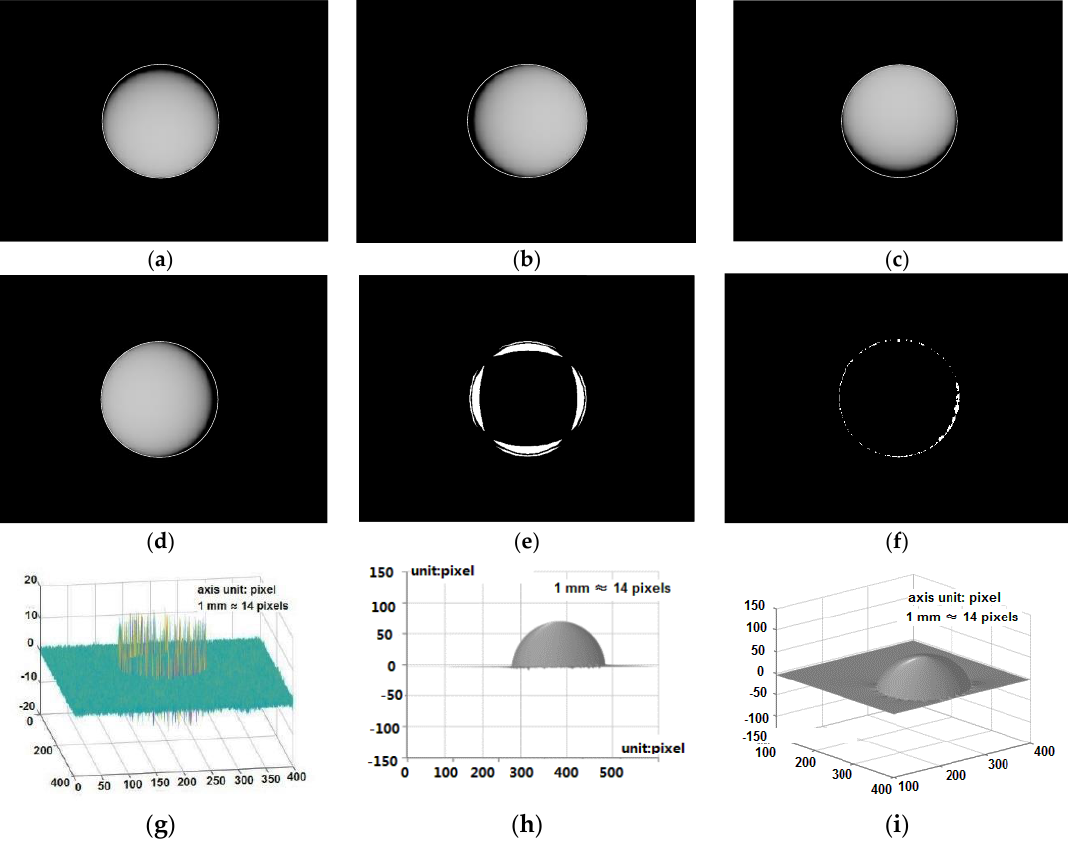
Figure 6. Simulated 3-D reconstruction of an “unknown” rigid sphere: ( a – d ) four sphere images with shadows, ( e ) shadow detection, ( f ) 3-D reconstruction error (absolute value projected to the bottom plane), ( g ) 3-D reconstruction error (absolute error <15 pixels, in contrast to the sphere height of 70 pixels), ( h , i ) 3-D reconstructed sphere.